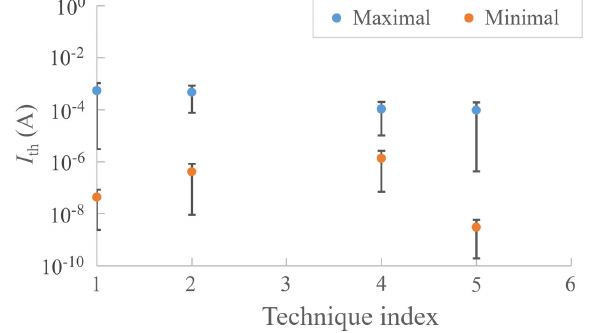
FIG. 15. Minimal and maximal threshold current values achiev- able with different BBU mitigation techniques for 10 randomized configurations of S-DALINAC.TABLE V. Effectiveness of different BBU mitigation tech-